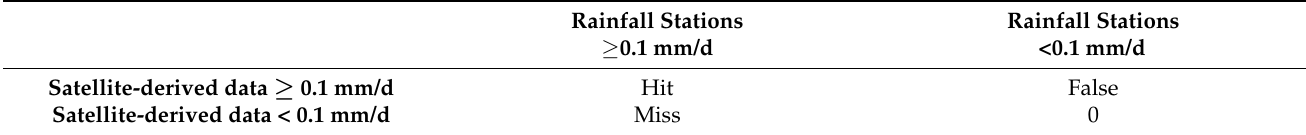
Table 2. Contingency table of the satellite-derived precipitation data and rainfall station data. Rainfall